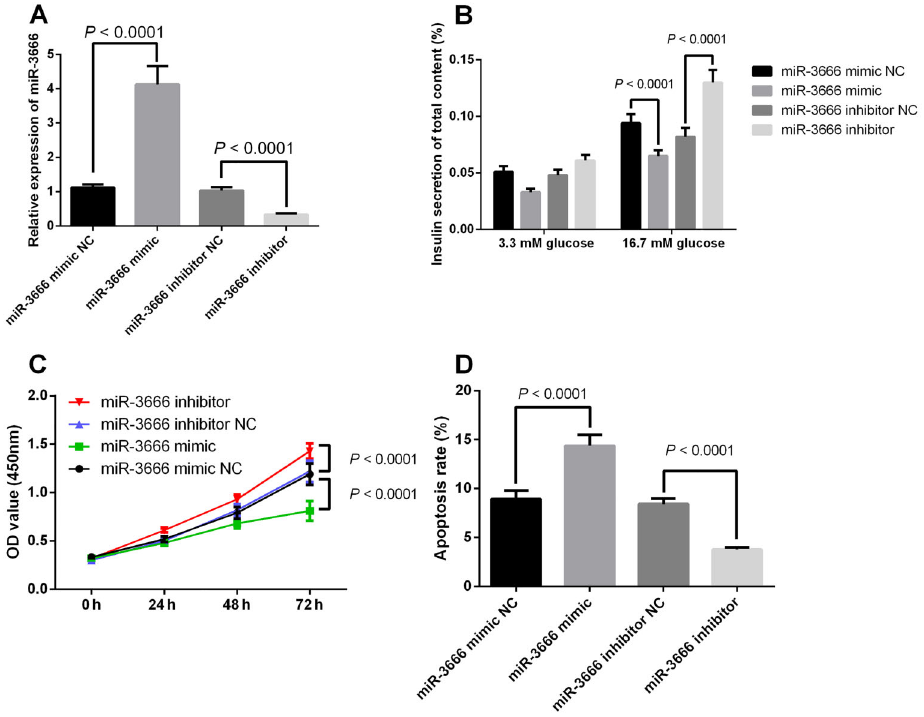
Figure 2. Effects of miR-3666 on the insulin secretion, cell proliferation and apoptosis of pancreatic b -cells. INS-1 cells were trans- fected with mimic-normal control (NC), miR-3666 mimic inhibitor-NC, or miR-3666 inhibitor. A , Relative expression of miR-3666. B , Glucose-stimulated insulin secretion was determined by ELISA assays. C , Cell proliferation was determined by CCK-8 assay. D , Cell apoptosis was determined by fl ow cytometry. Data are reported as means ± SE (n=3) and were compared with the t -test or ANOVA.